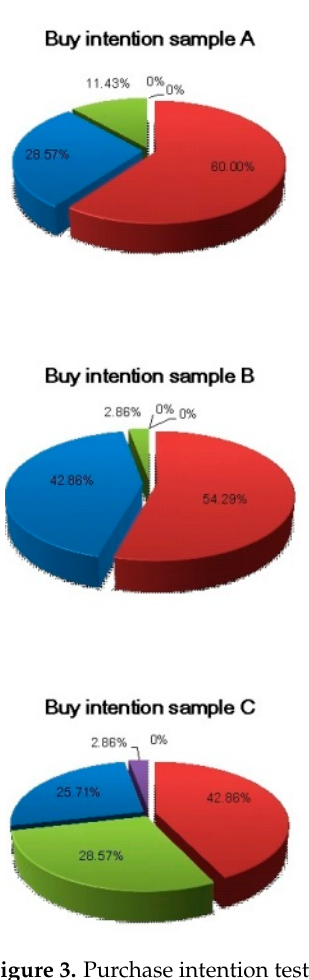
Figure 3. Purchase intention test.